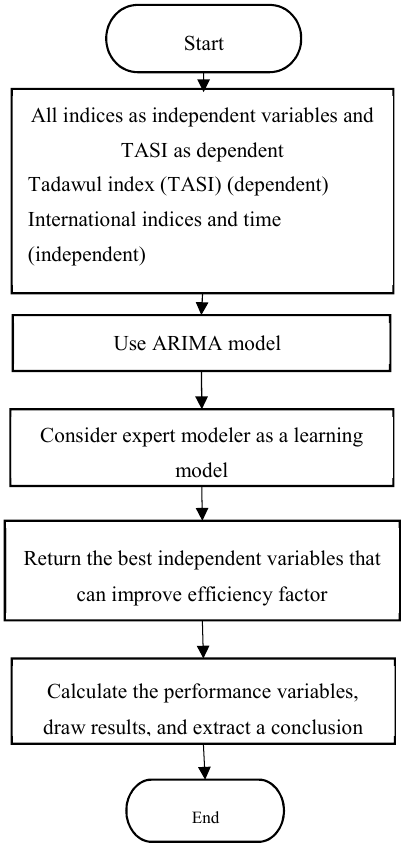
Figure 2. ARIMA model flowchart.